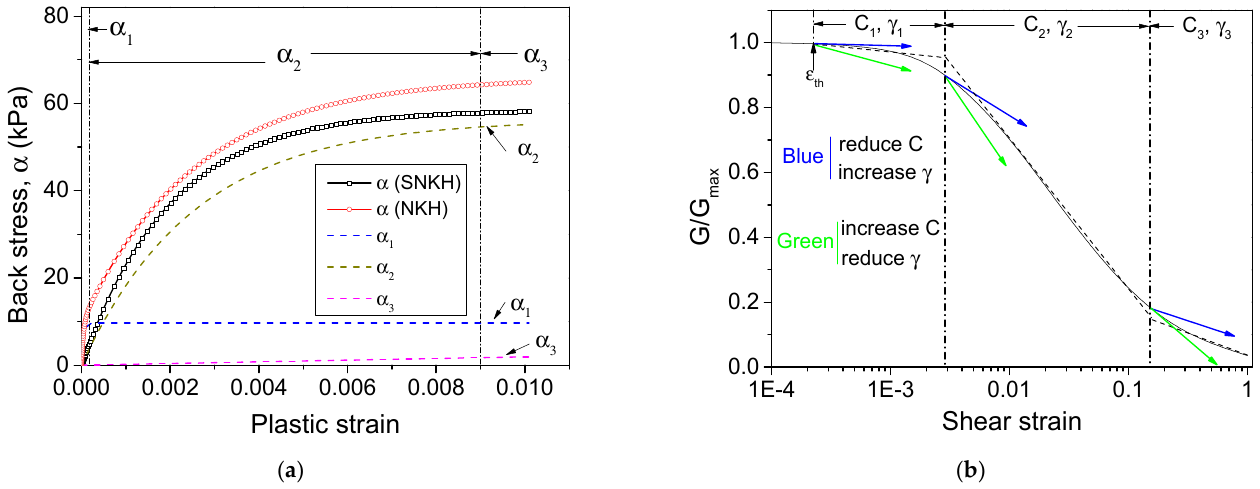
Figure 3. ( a ) Back-stress curves for silica sand, and ( b ) the estimation of NKH model parameters for each part of the G/G max curve.